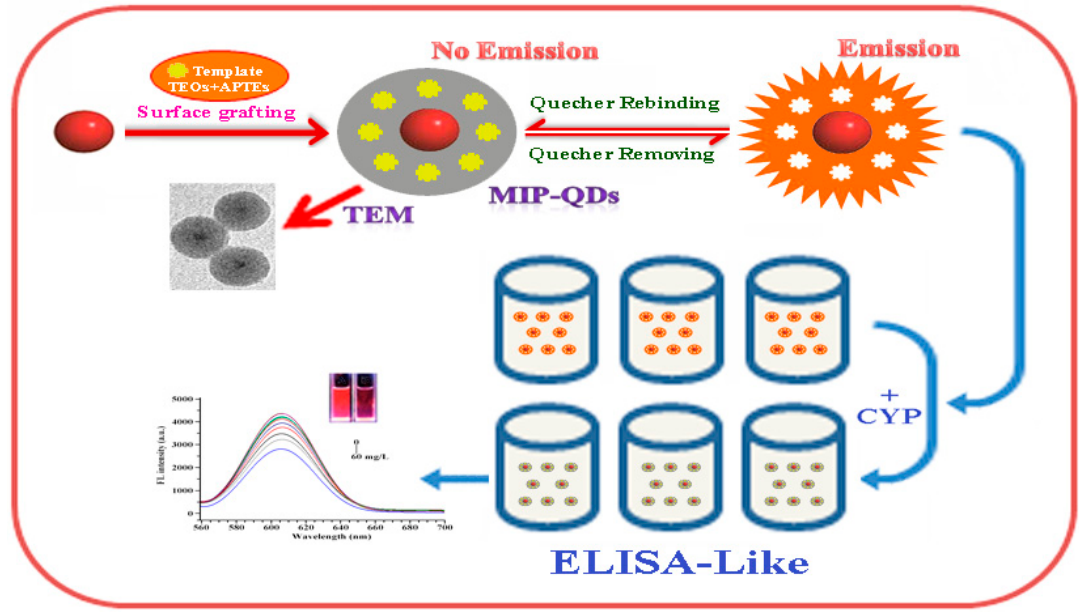
Figure 9. An ELISA-like method based on the MIP-QDs to monomer cypermethrin in the samples